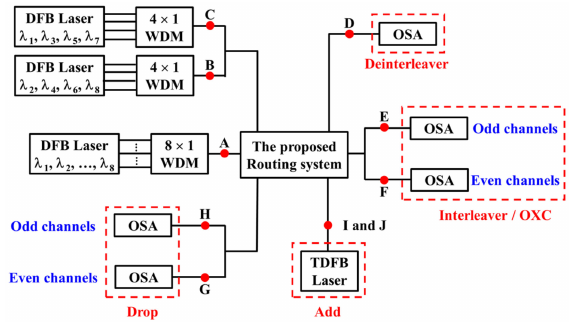
Figure 2. Experimental setup for the demonstration of the proposed optical routing